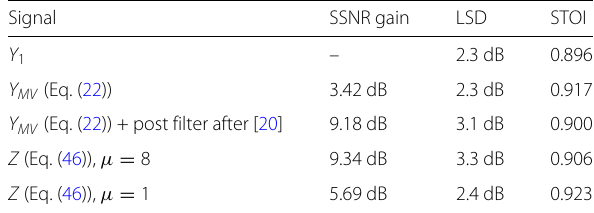
properties with this noise recording are only valid for frequencies below 600 Hz (cf. Fig.